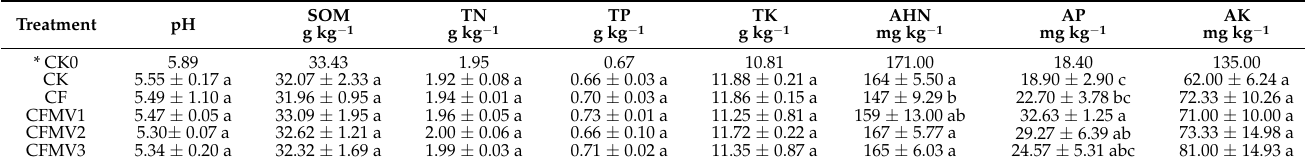
Table 1. Soil properties at the rice harvesting